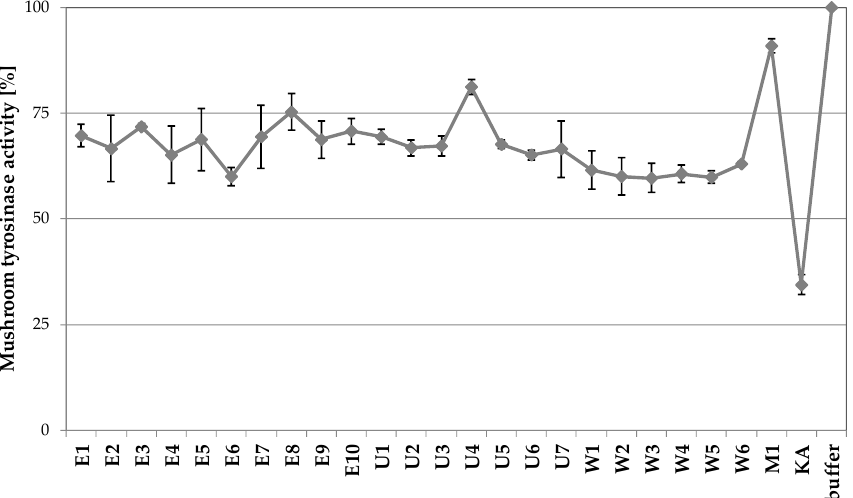
Figure 2. Mushroom tyrosinase inhibitory properties of A. biebersteinii extracts (100 µ g/mL) prepared using various extraction protocols; 100 µ g/mL kojic acid (KA) was used as a positive control; graph shows mean values ± SD, n = 3. E—ASE extracts, U—ultrasounds extracts, W—shaking extracts, M—maceration extract.